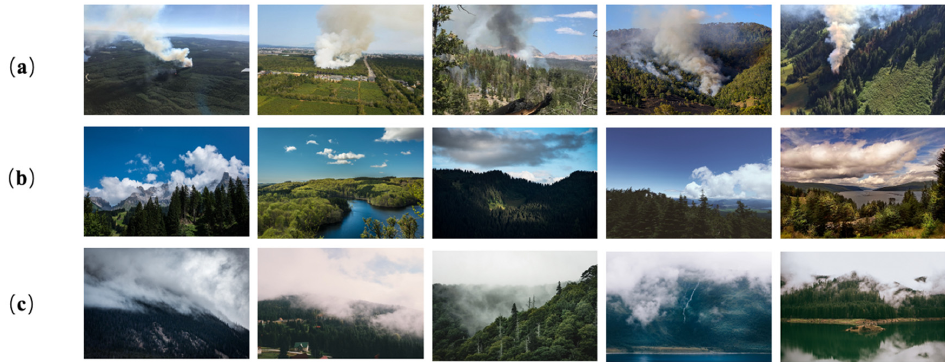
Figure 1. Smoke and interference images. ( a ) Smoke images, ( b ) cloud images, ( c ) fog images.